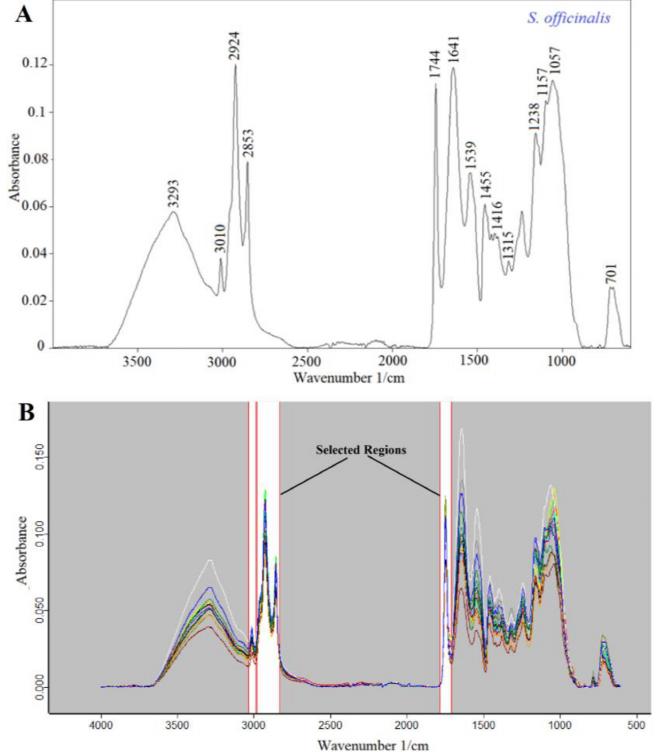
Figure 3. ( A ) Fingerprint Fourier transform infrared spectroscopy-attenuated total reflectance (FTIR-ATR) spectrum of S. o ffi cinalis seed ( B ) Overlapped FTIR spectra of all Salvia